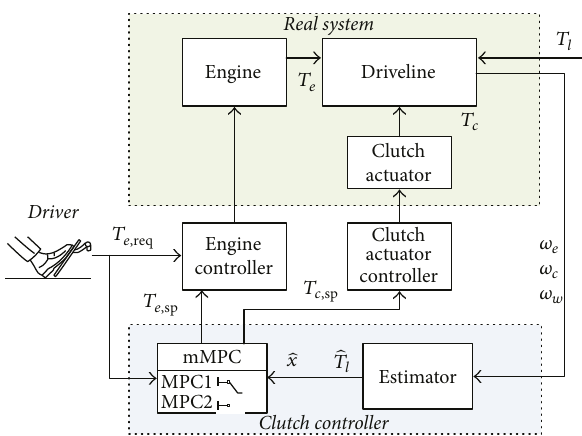
Figure 5: mMPC based clutch controller